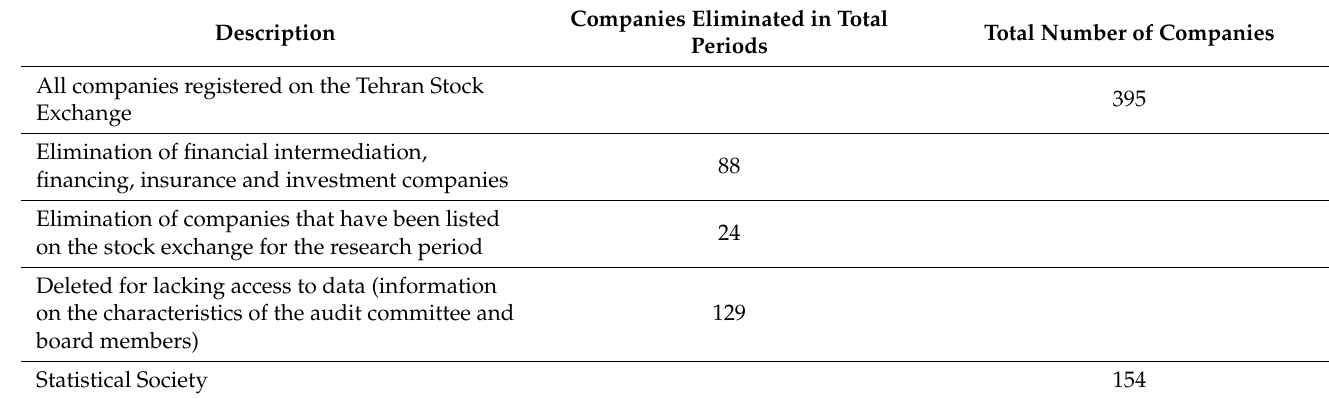
Table 1. Number of companies in the statistical community and application of conditions for sample